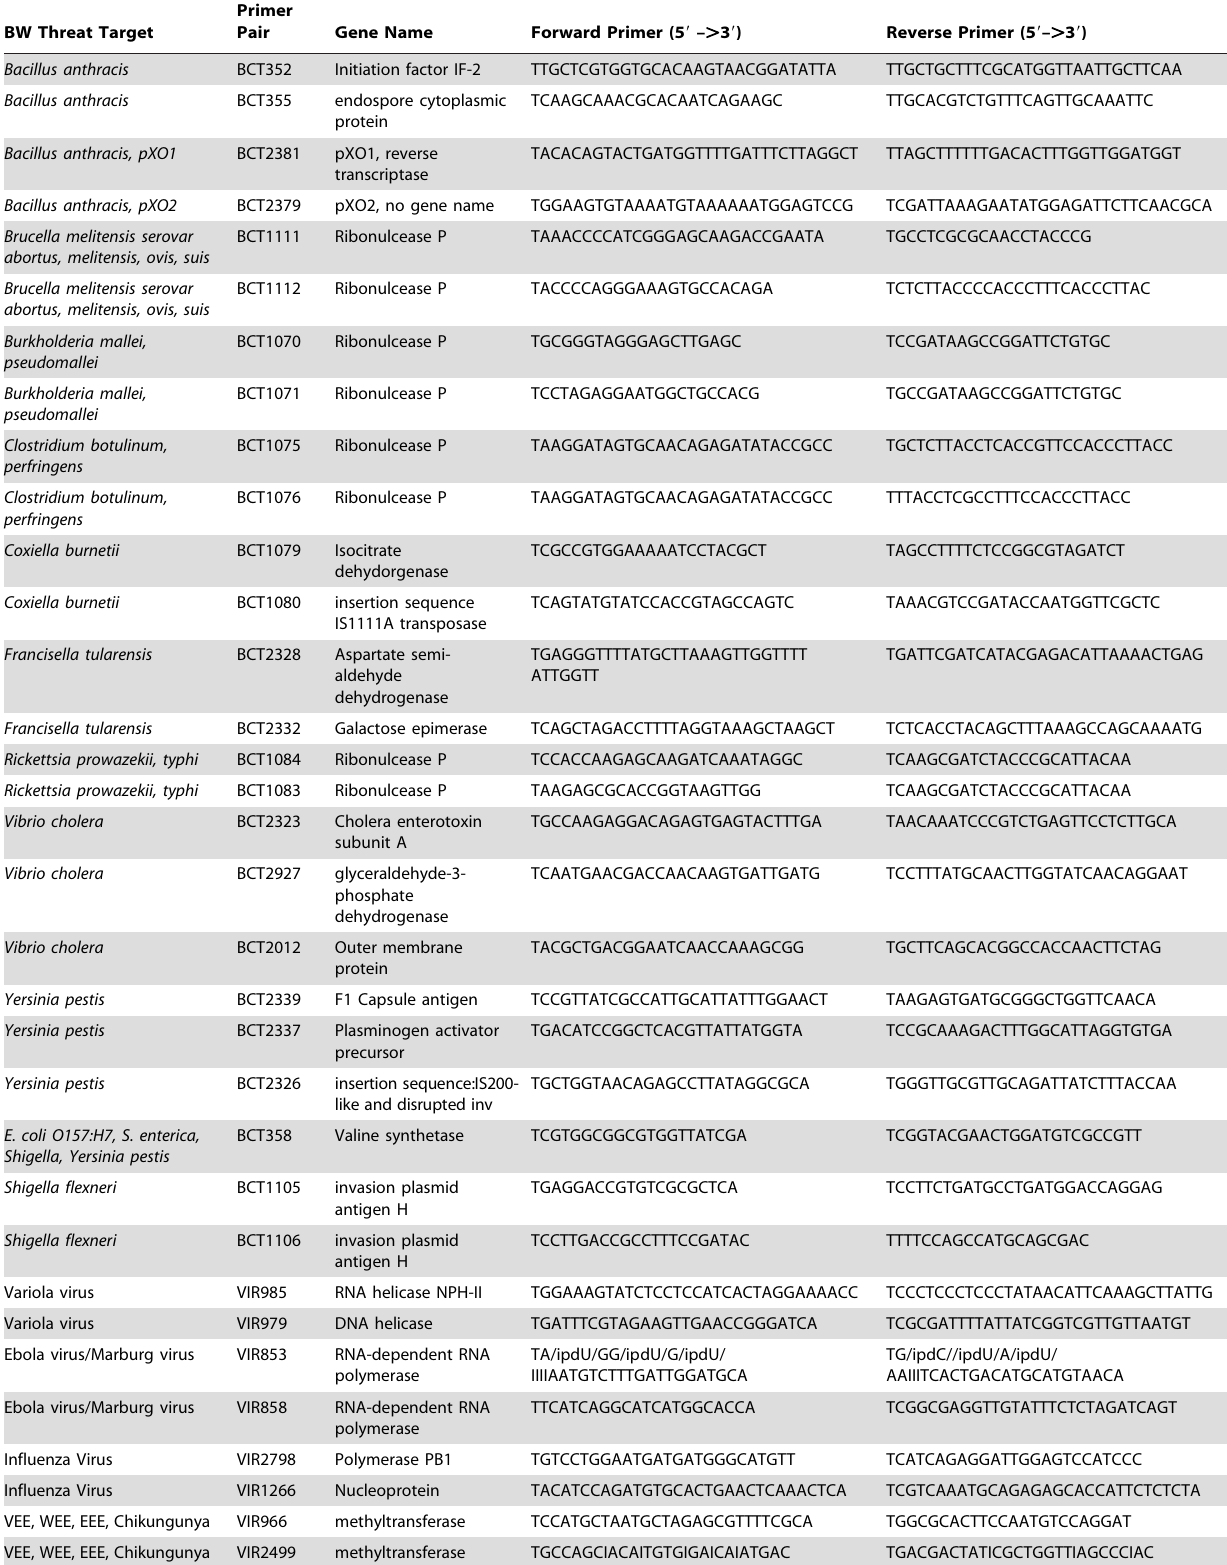
Table 1. Biothreat cluster detection primer pair and target